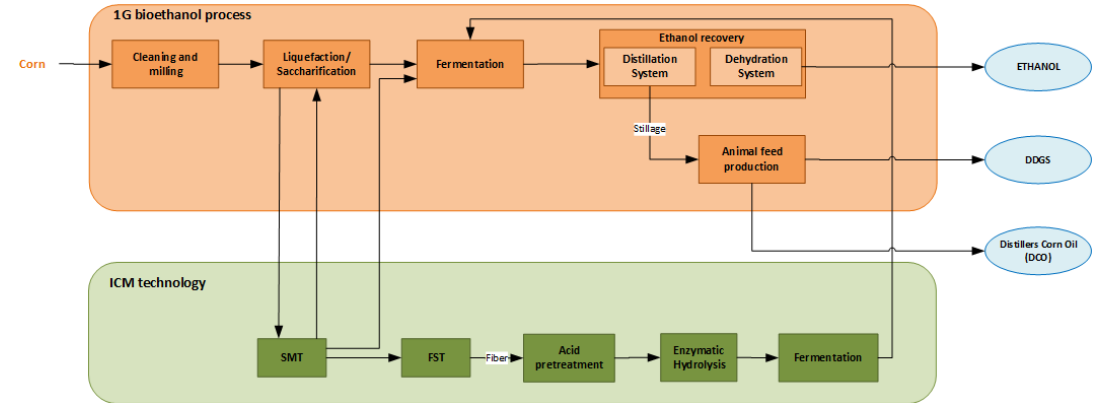
Figure 10. Schematic diagram of ICM technology (adapted from [146]).